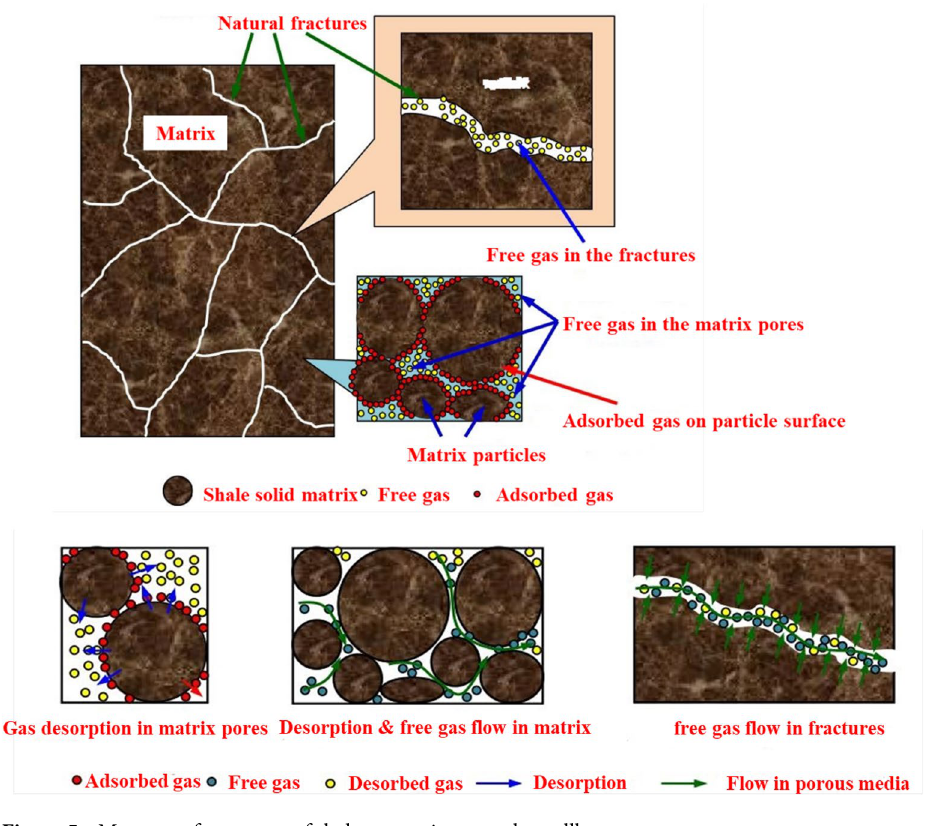
Figure 5. Mass transfer process of shale reservoir gas to the wellbore.